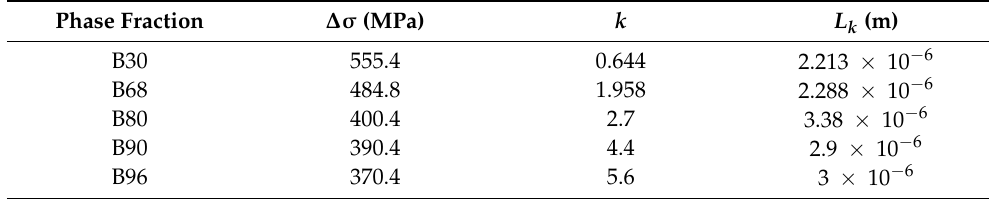
Figure 9. Comparisons of flow curves determined by RVEs with experimental results (the dots represent experimental values and the lines represent simulated values in RVE). Table 5. Determined constants used for prediction the flow curves of the specimens with varying bainite volume fractions.